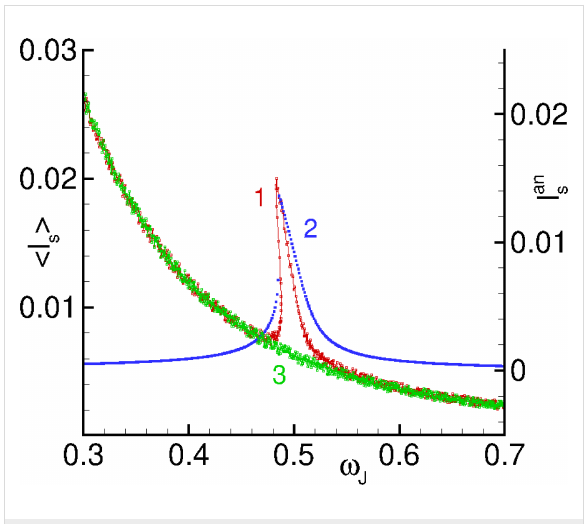
Figure 9: Numerically calculated superconducting current for SFS junction (plot 1) and analytical I 0 (plot 2) and superconducting current for SIS junction (plot